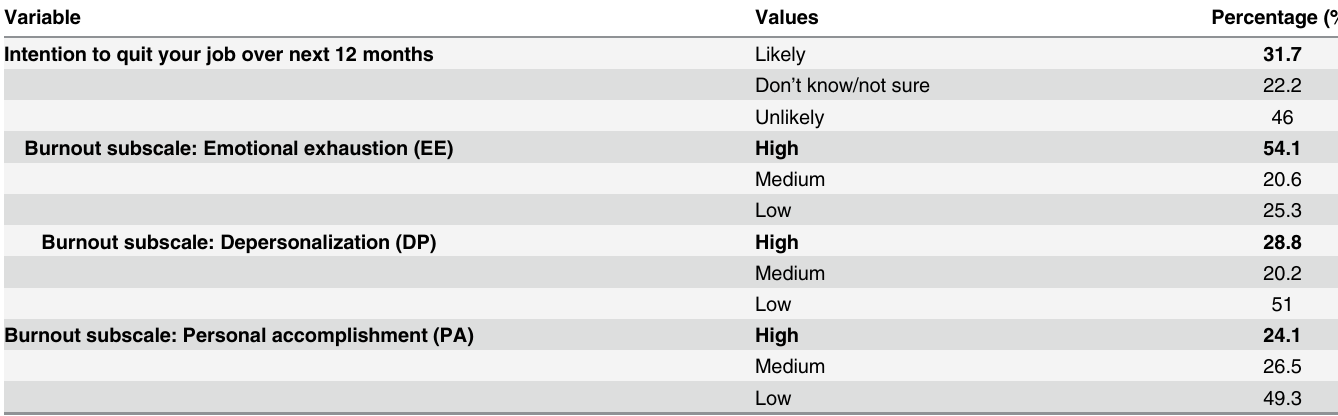
Table 3. Intention to quit and level of burnout among surveyed nurses.